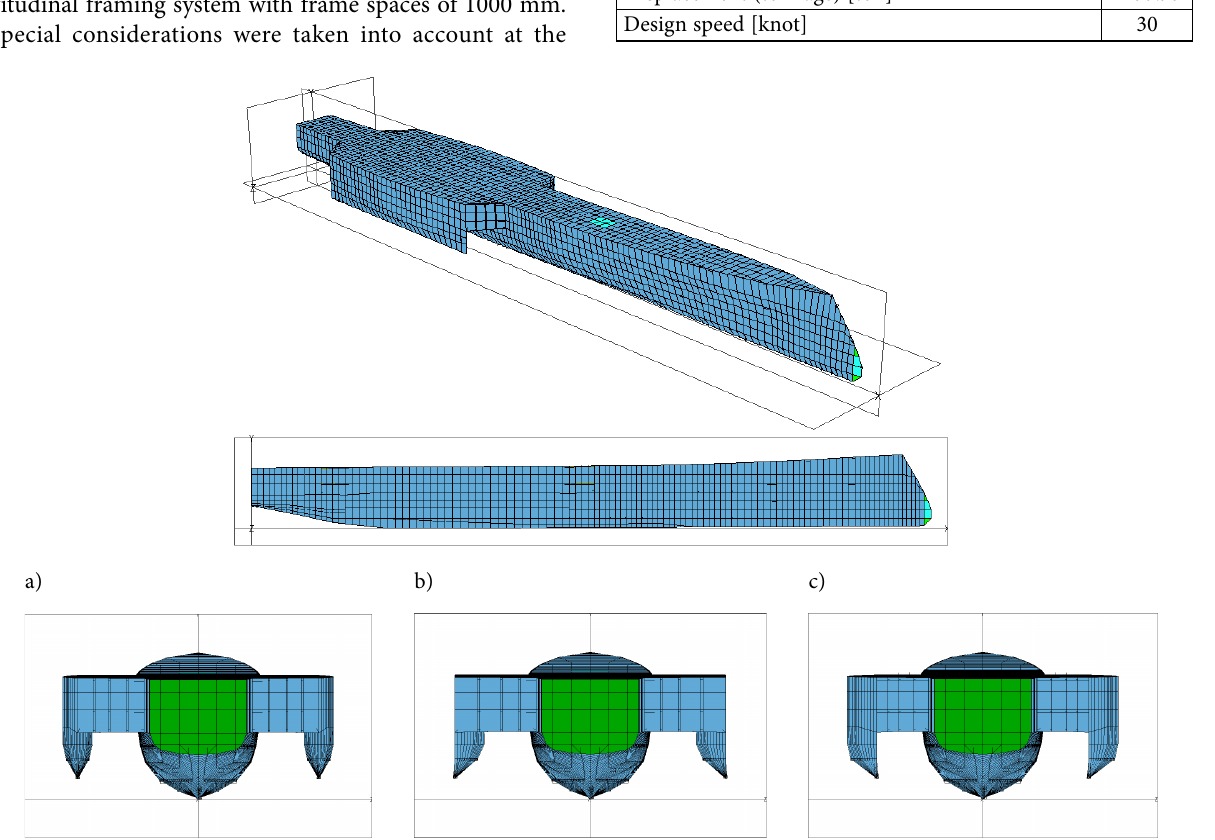
Figure 1. FE model of trimaran and three kinds of side-hull forms: a – symmetric; b – inboard; c –